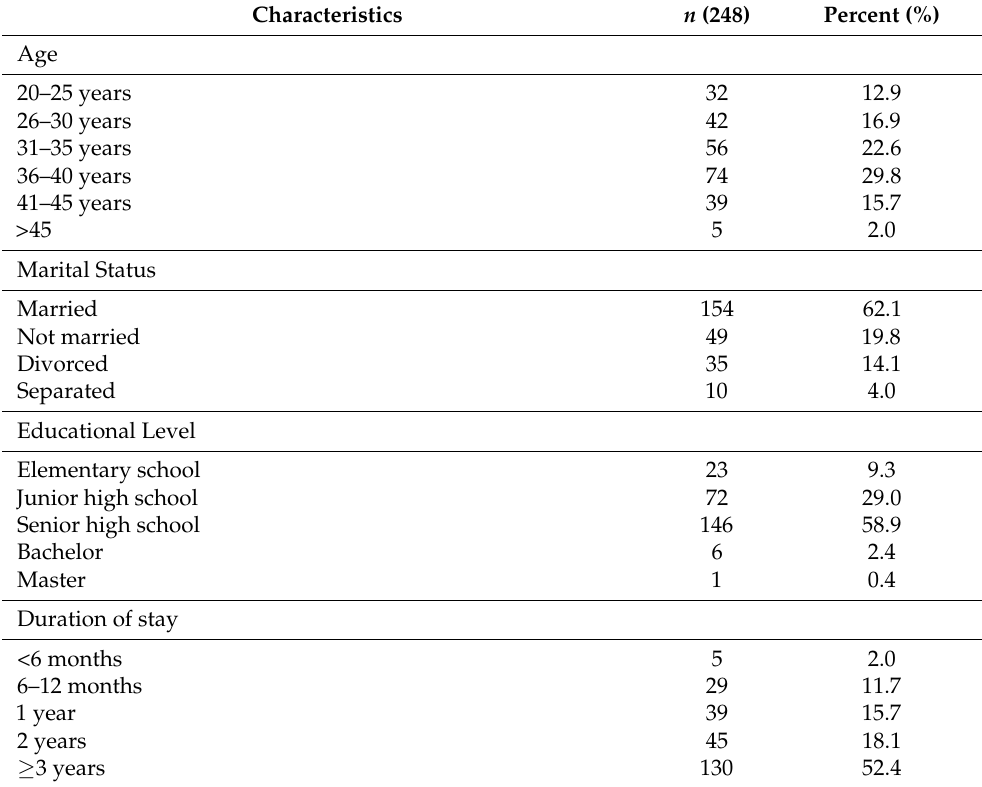
Table 2. Socio-demographic characteristic of the participant ( n =